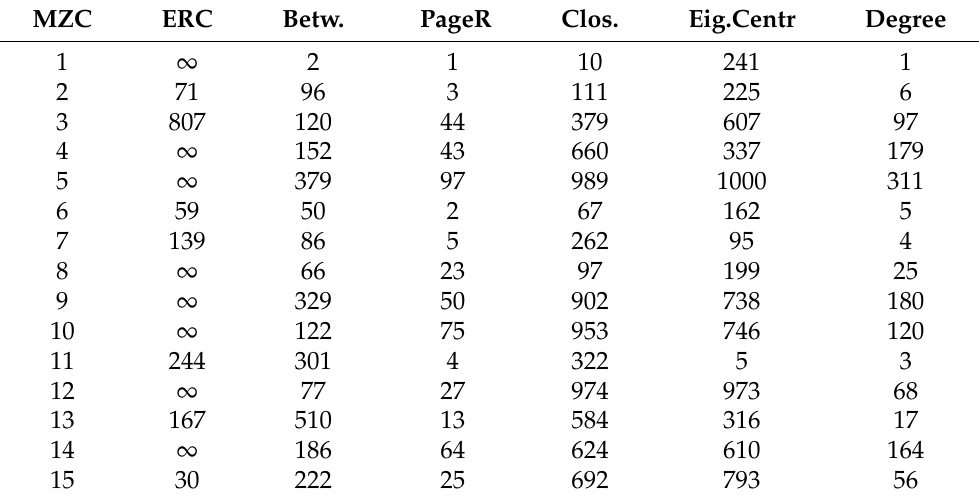
Figure 12. Kendall Tau correlation between Modified zagreb index centrality, Effective resistance centrality, Closeness centrality, Betweenness centrality, Eigenvector centrality, Pagerank centrality, and Degree. ( a ) European Road Network. ( b ) U.S. Power Grid Network. Table 2. The most important vertices of European Road network are ordered in terms of Modified Zagreb Index Centrality. MZC